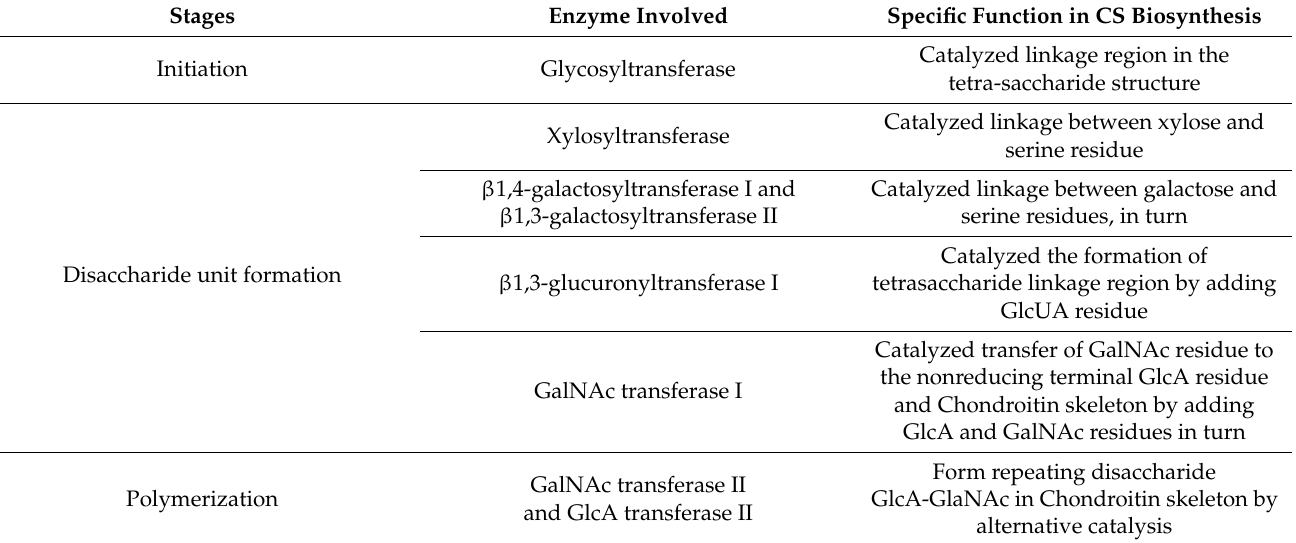
Table 1. Functions of enzymes involved in CS